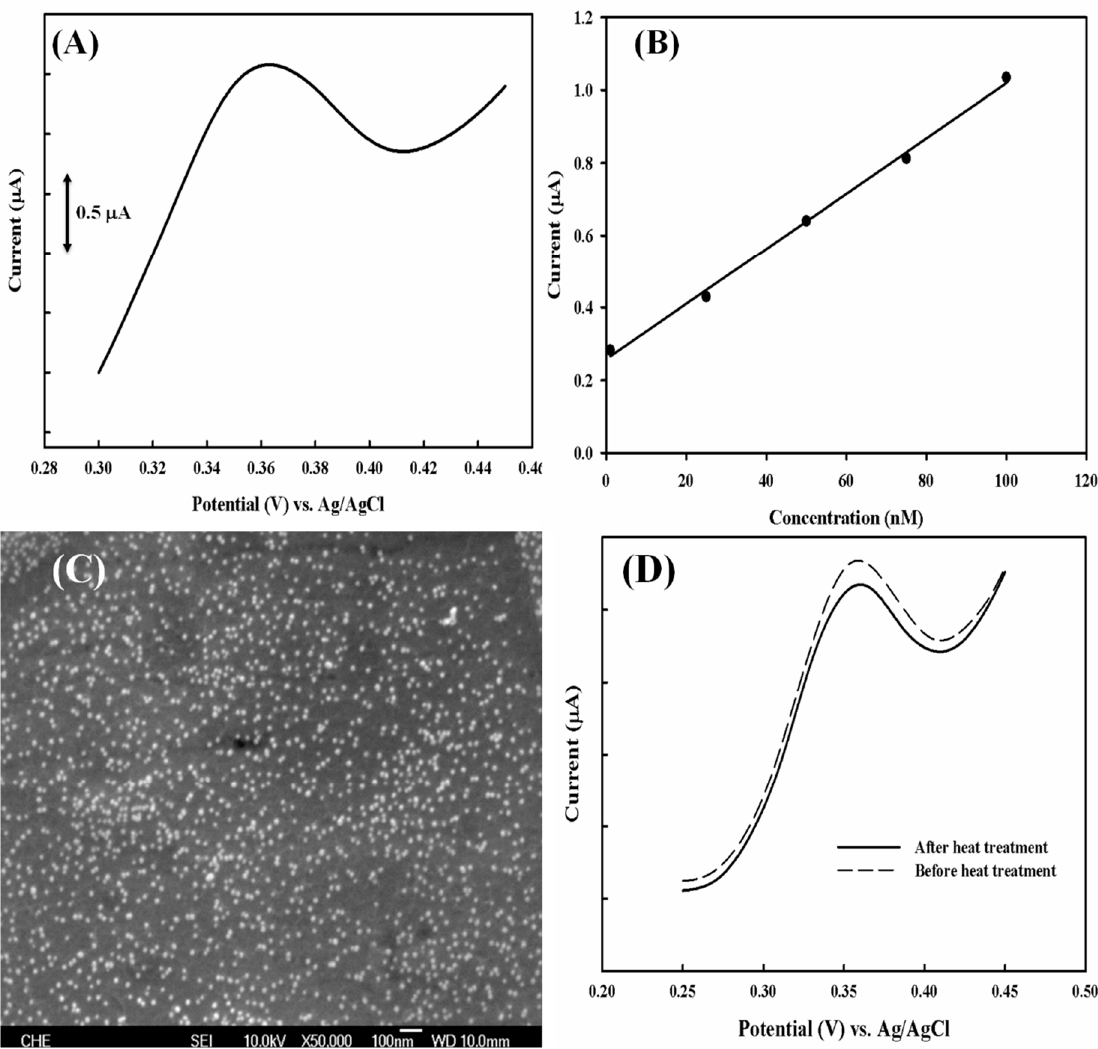
Figure 5. ( A ) DPV profile of ssDNA-AuNP-PEDOT/PEDOT:PSS/Pt in response to 75 nM of complementary target DNA. ( B ) The linear correlation between the peak current and the concentration of target DNA. ( C ) SEM image of ssDNA-AuNP-PEDOT/PEDOT:PSS/Pt electrode after heat treatment at 90 °C for 10 min. ( D ) DPV profiles in response to 50 nM of complementary DNA before (dotted line) and after (solid line) heat treatment.